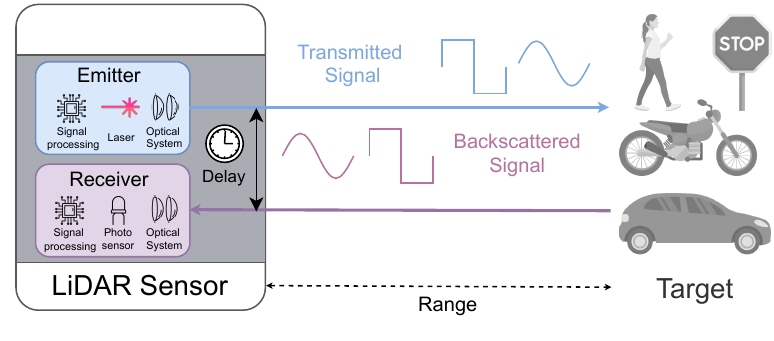
Figure 2. LiDAR working